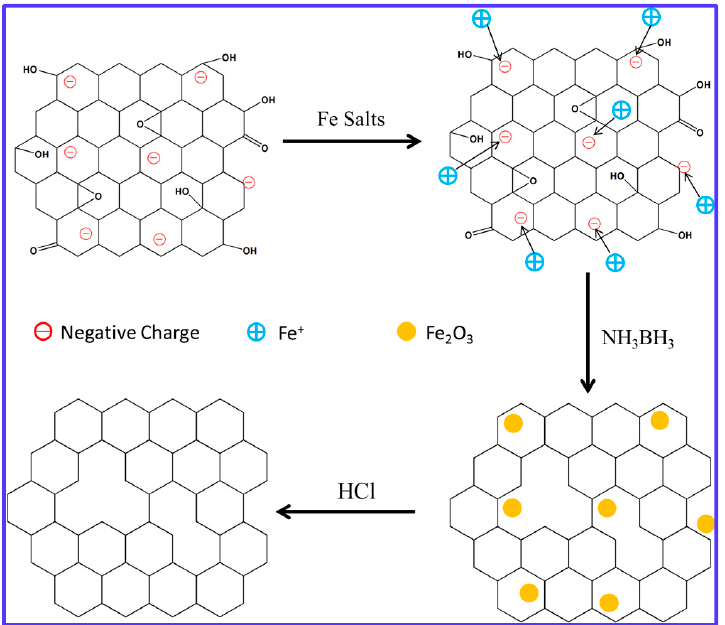
Figure 1. Schematic of reducing GO sheets .